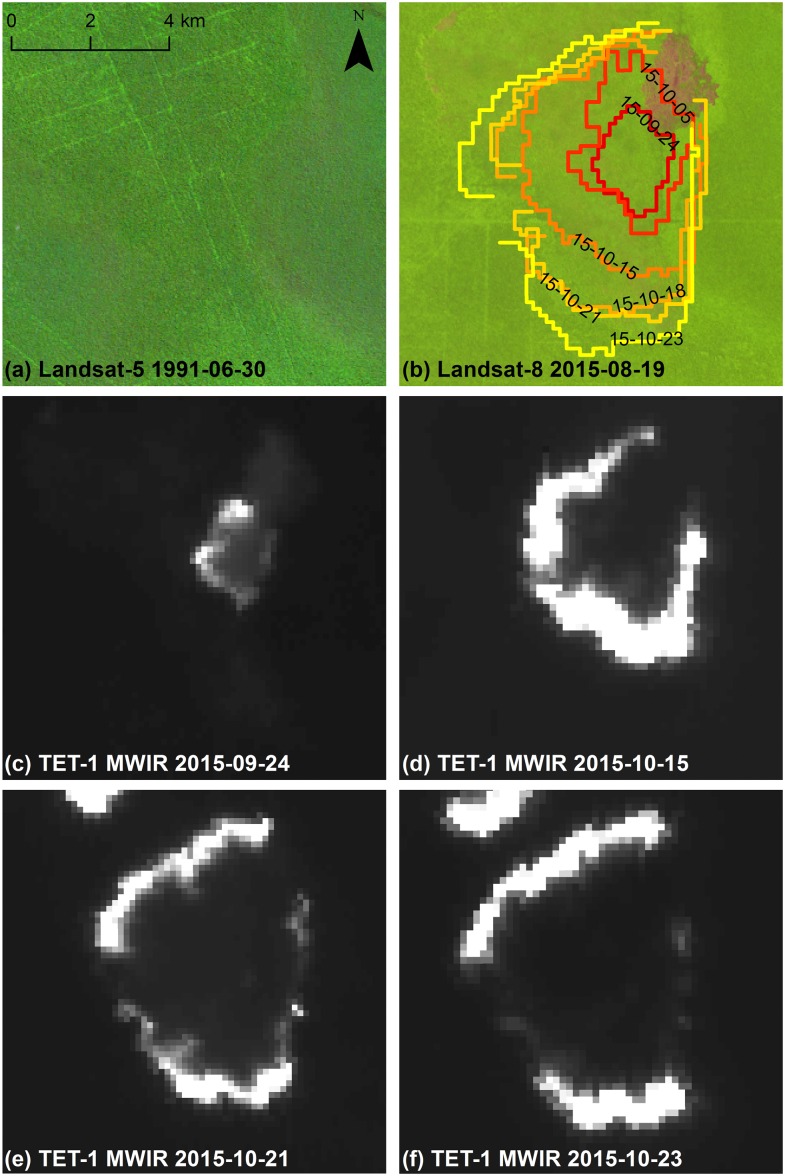
Asymmetric ring fire front (F02) time series.(a) Landsat-5 TM imagery (false color: R, band 5 1.55–1.75 μm; B, band 4 0.76–0.90 μm; G, band 3 0.63–0.69 μm; source USGS/NASA) from June 30th, 1991, showing historical logging railway infrastructure. (b) Landsat-8 OLI imagery (false color: R, band 9 1.36–1.38 μm; G, band 5 0.85–0.88 μm; B, band 4 0.64–0.67 μm; source USGS/NASA) from Aug. 19th, 2015, overlain with TET-1 detected fire front time series from six acquisition dates. Recently burned area prior to fire event is located along the northeastern fire edge. Original TET-1 midwave infrared (MWIR; source DLR FireBird Mission) imagery is shown for (c) Sept. 24th, (d) Oct. 15th, (e) Oct. 21st, and (f) Oct. 23rd, 2015.